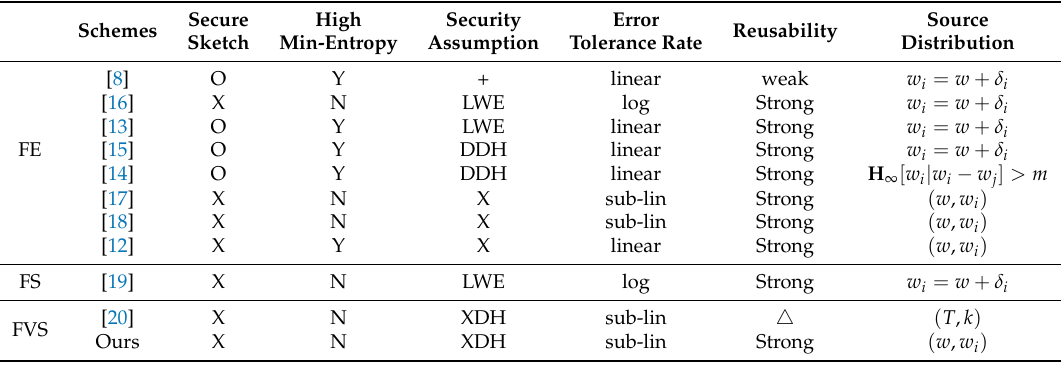
Table 1. Comparison with reusable biometric